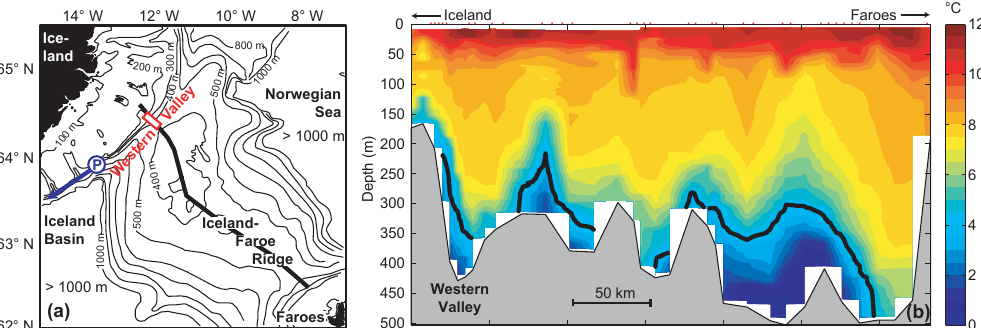
Figure 2. (a) Bottom topography of the Iceland–Faroe Ridge with isobaths for every 100m down to 1000m depth. The red rectangle in the Western Valley indicates the instrument deployment sites of our field experiment. The blue circle marks site P and the blue arrow indicates the strong and persistent bottom current at this site reported in previous studies. The thick black line along the ridge crest indicates a conductivity–temperature–depth (CTD) section occupied by R/V Poseidon in August 2016. (b) The potential temperature distribution along that section is shown as background colour with the black line indicating the σ θ = 27 . 8kgm − 3 isopycnal, commonly used as the upper boundary of the overflow layer.